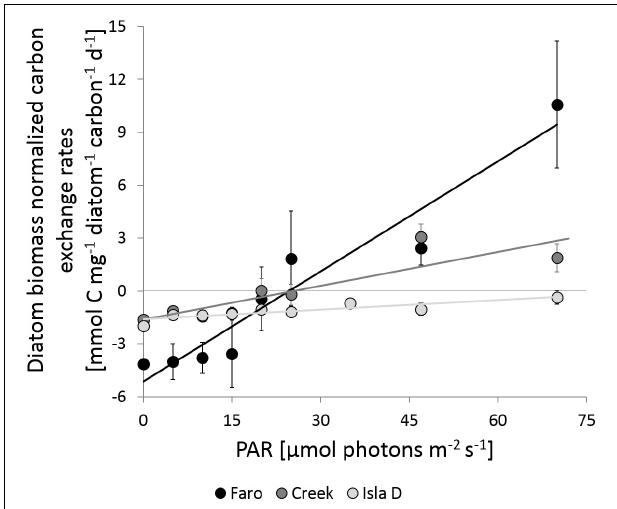
FIGURE 4 | Carbon exchange rates normalized by the mean diatom carbon content at different PAR intensities. The linear regression for Faro, Creek, and Isla D is y = 0.208 – 5.126 ( R 2 = 0.925), y = 0.064 – 1.618 ( R 2 = 0.781, and y = 0.0178 – 1.591 ( R 2 = 0.779),